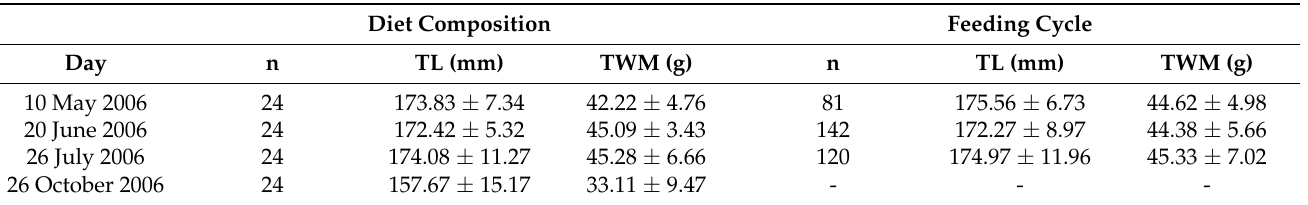
Table 2. Information about fish considered for diet composition analysis and for feeding cycle: number (n), total length ± st. dev. (TL), total wet mass ± st. dev. (TWM). Diet Composition Feeding Cycle